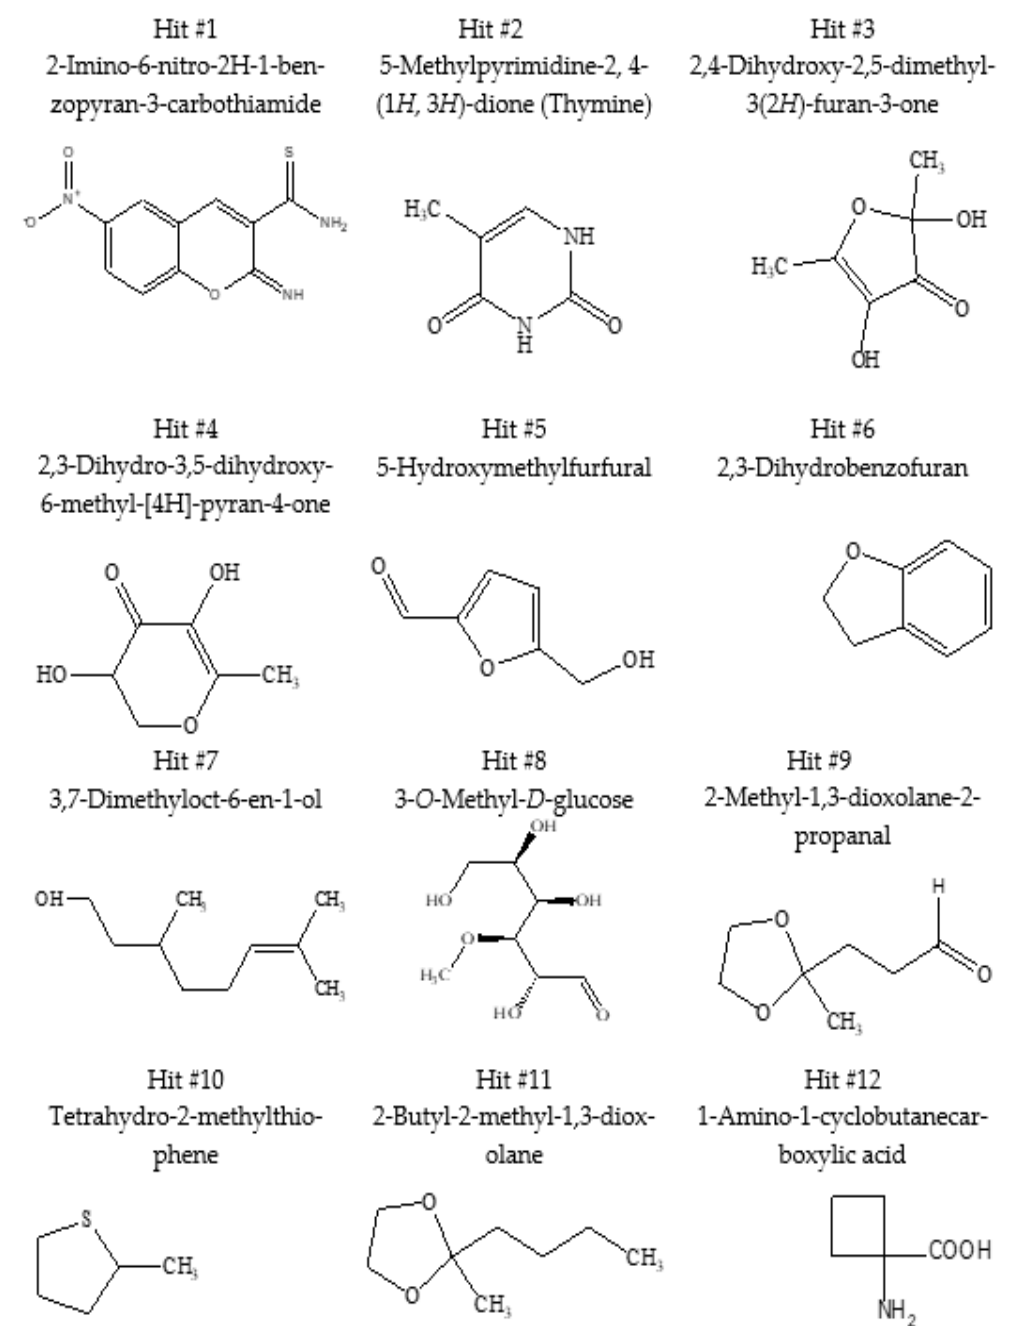
Figure 3. The chemical structures of bioactive compounds extracted from J. procera leaves and used in molecular docking experiments.